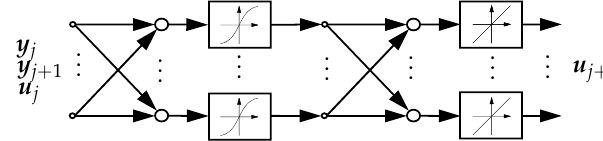
Figure 4. Structure of the neural network of the kinematic